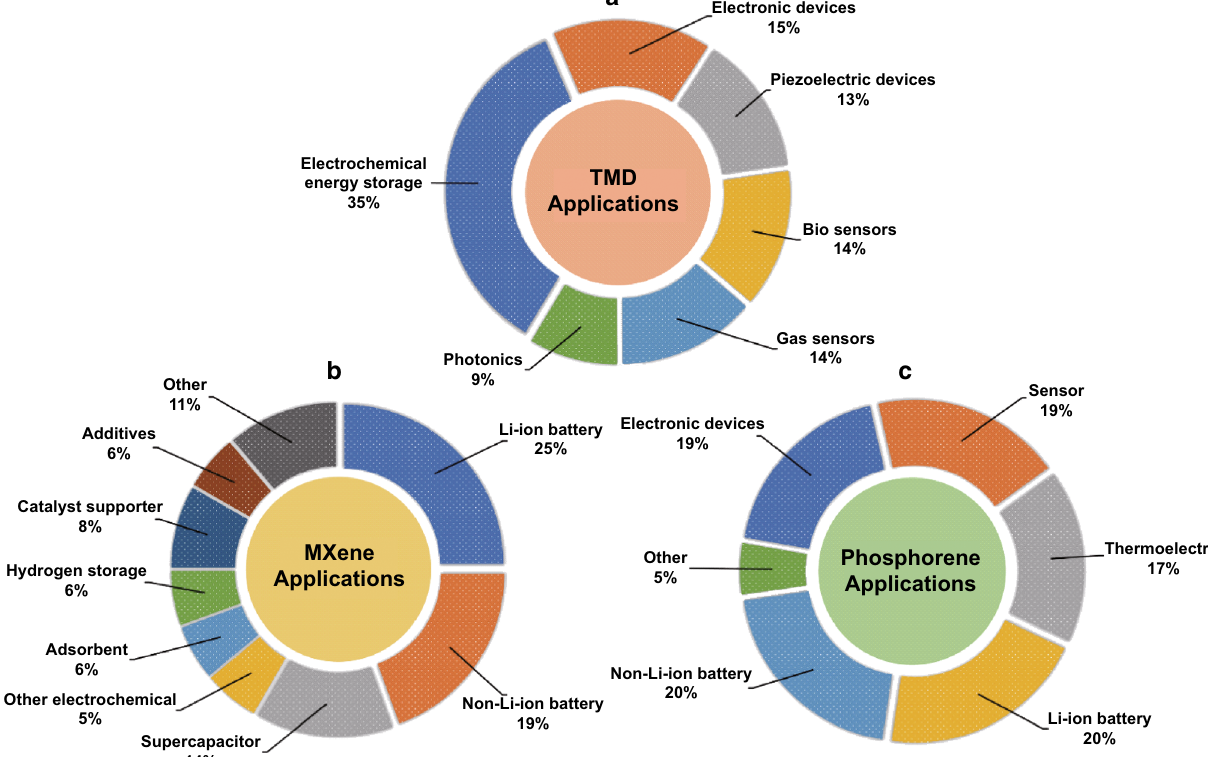
Fig. 2 Statistical analysis of the application of beyond graphene 2D materials: a – c Pie chart analysis showing the weight of the various applications of TMDs, MXene, and phosphorene, respectively. Electrochemical energy storage occupies an important role in the application regimes of each of the 2-D materials, which is indicative of the current trend of their applications in batteries and